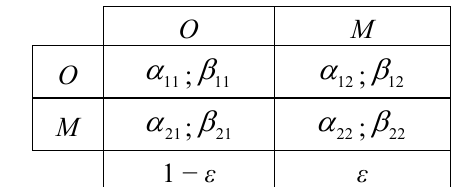
Table 1. SG matrix, Optimization Stability Analysis (1).